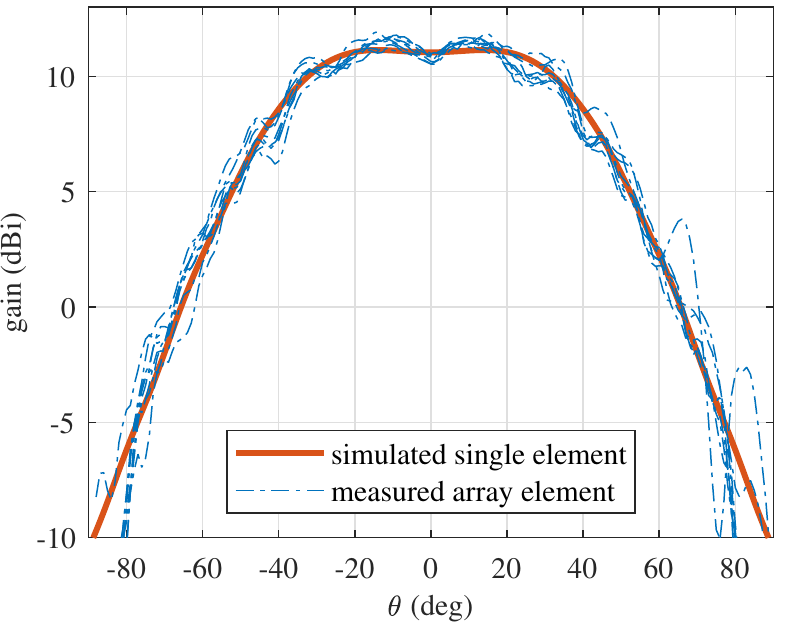
Figure 14. Measured radiation patterns of each antenna element when the array is configured as a regular array. The simulated single element, when considering an infinite ground plane, is overlaid. A measurement of the gain was not taken, but each pattern was normalized to the simulated gain at θ = 0 ◦